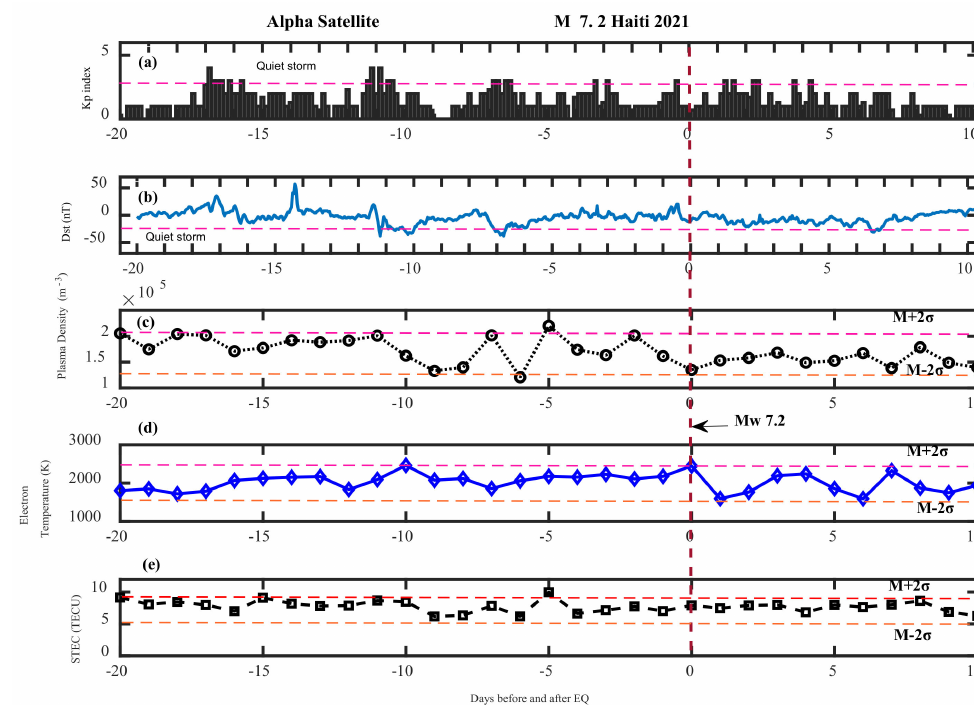
Figure 6. ( a ) and ( b ) The storm display of Dst and Kp for M w 7.2 (Haiti). ( c ) Plasma density, ( d ) Electron Temperature (ET), and ( e ) STEC of Swarm-A for M w 7.2 (Haiti). The red dashed line represents the EQ day.